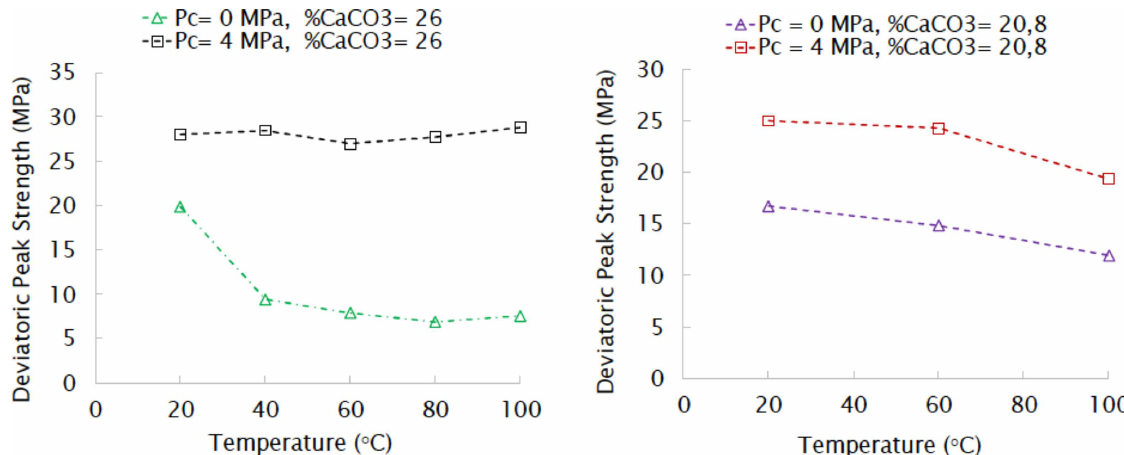
Fig. 4. Evolution of the peak strength of COx claystone as a function of temperature: at left the parallel orientation, at right the perpendicular orientation (from [9]).